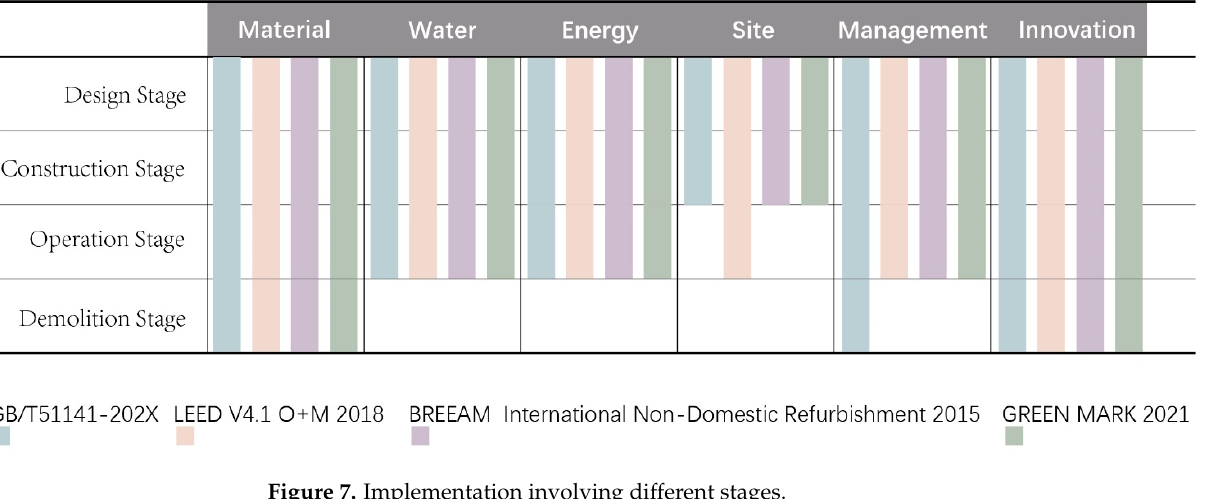
Figure 7. Implementation involving different